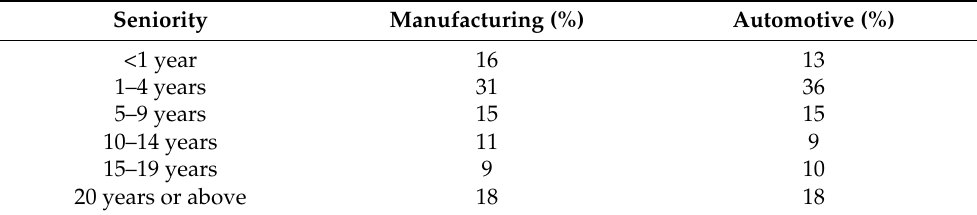
Table 5. Distribution of seniority in the automotive and manufacturing sectors in Portugal in